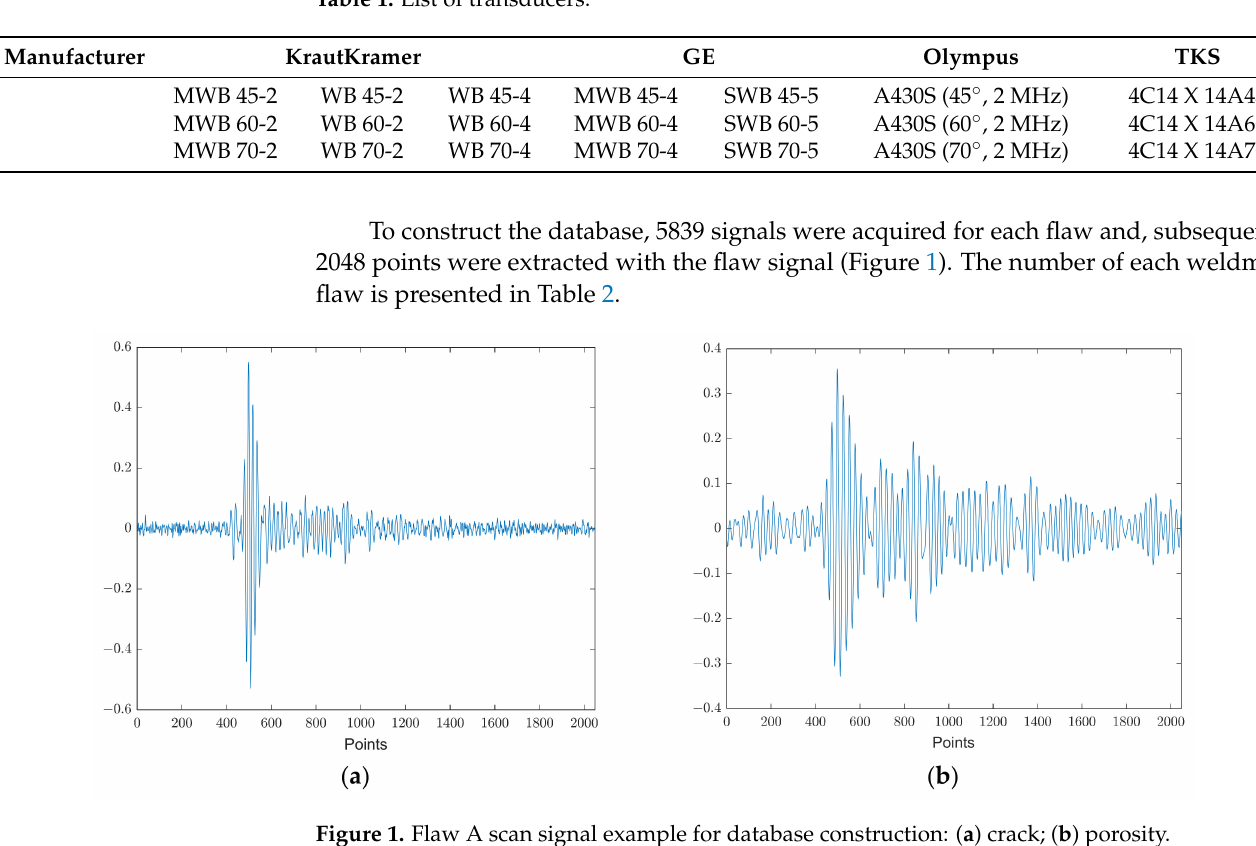
Table 1. List of transducers.